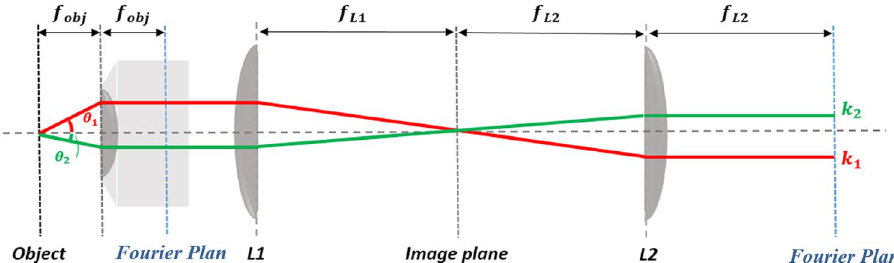
Figure 5. A scheme of the Fourier imaging setup.